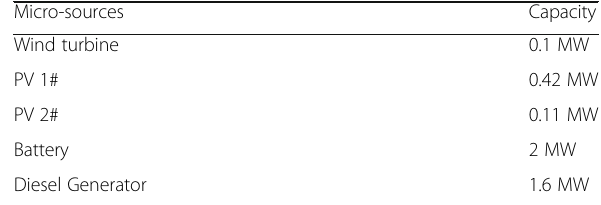
Table 1 The capacity of the micro-sources